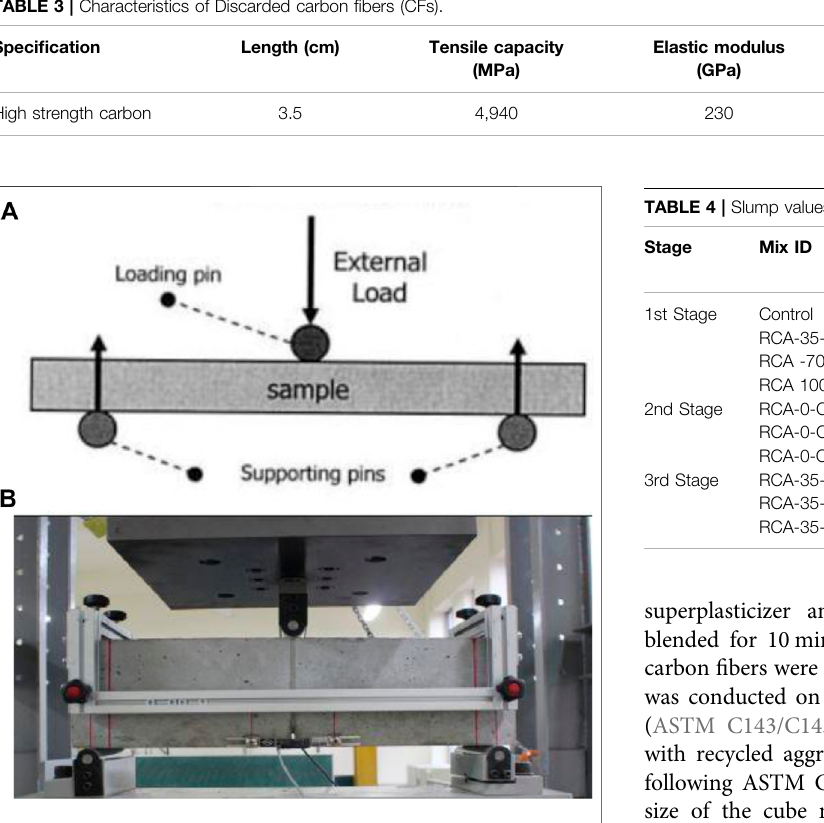
FIGURE 3 | (A) Schematic diagram for fl exural testing of samples. (B) Test setup for fl exural strength of samples.